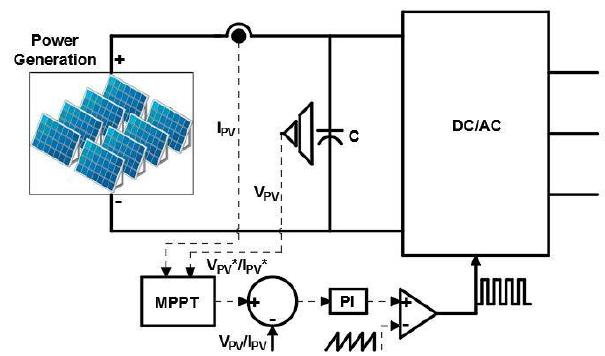
Figure 4. Block diagram of PV generation with the maximum power point tracking (MPPT) technique.